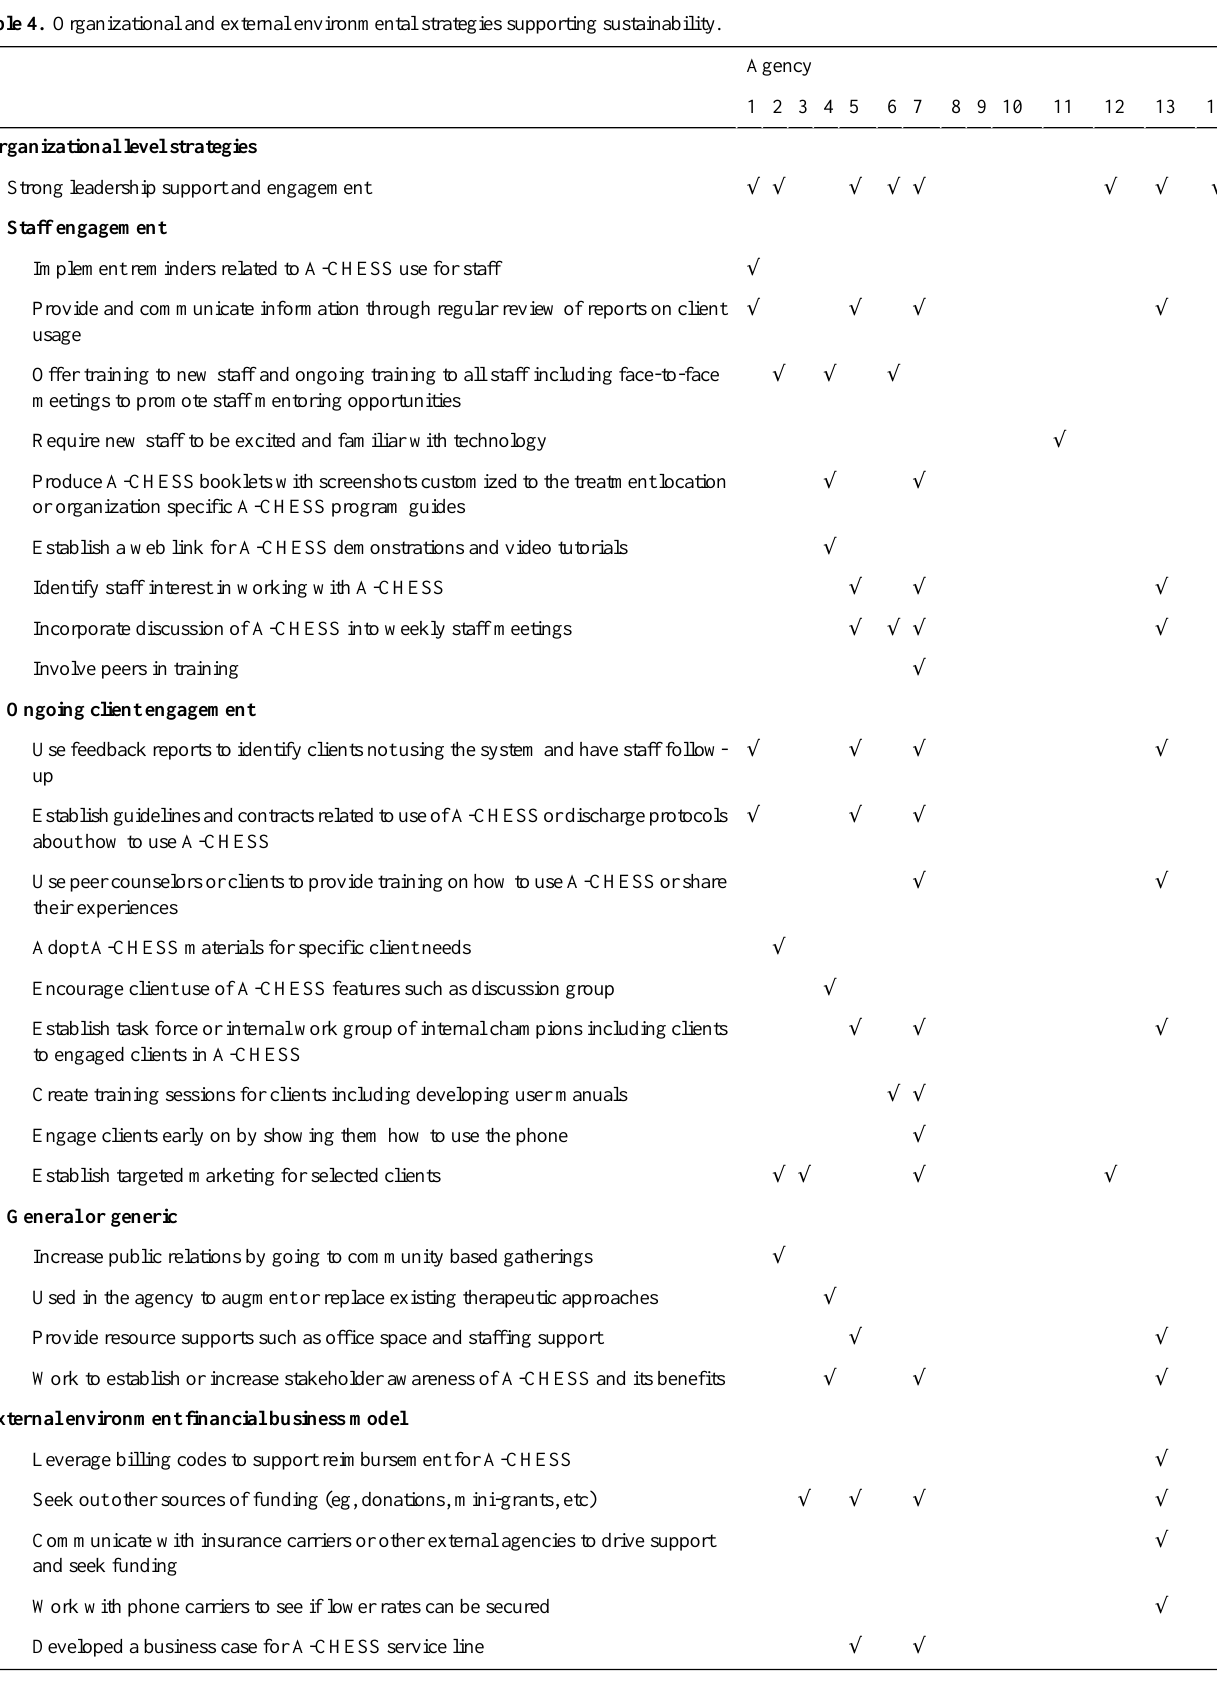
Table 4. Organizational and external environmental strategies supporting